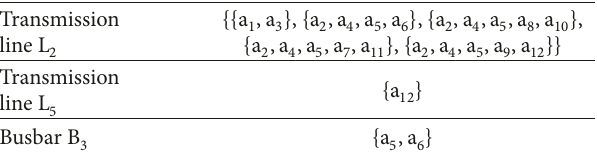
Table 6: Failure